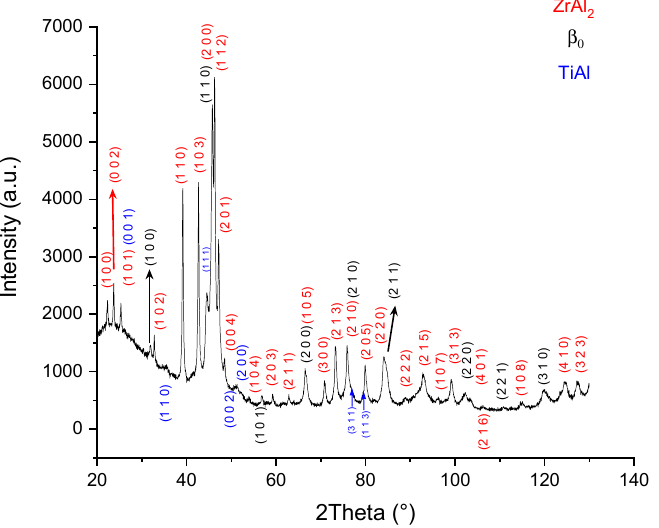
Figure 10. XRD analysis of Z4 (Ti-43.3Al-16.1Zr at. %) heat treated at 1300 °C/24 h. Kainuma et al. [6] investigated phase equilibria among β Ti,Zr( β 0 ), α Ti, and TiAl at 1300 °C. They located the position of the narrow β Ti,Zr( β 0 ) + α Ti + TiAl three-phase field based on the established compositions of the neighbouring two-phase fields. Figure 11 shows that compositions determined in [6] agree with the current results. The small dashed tie triangles β 0 + α Ti + TiAl in Figures 9 and 11 are derived from the combined results shown in Figure 11.